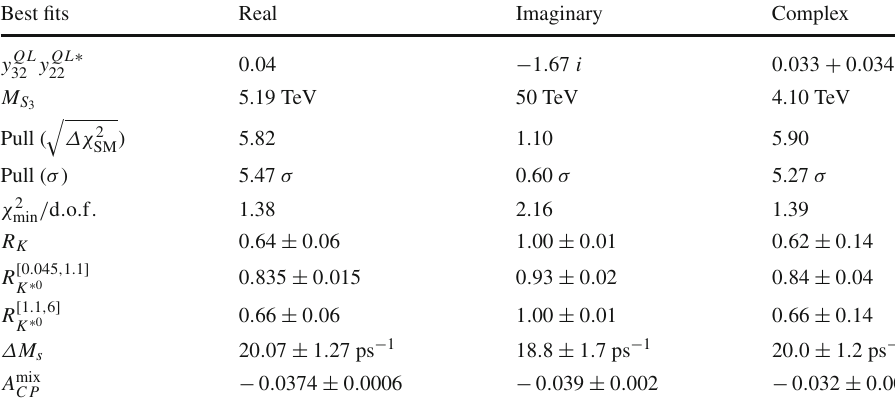
to R K , R K ∗ 0 ,Δ M s and A mix ; CP considering real, imaginary and complex Wilson coefficients on the S 3 leptoquark. Shown are also the corresponding pulls, χ 2 / d . o . f . and the predictions min for semi-leptonic decay observables R K , R K ∗ 0 ; Δ M s and A mix with 1 σ CP